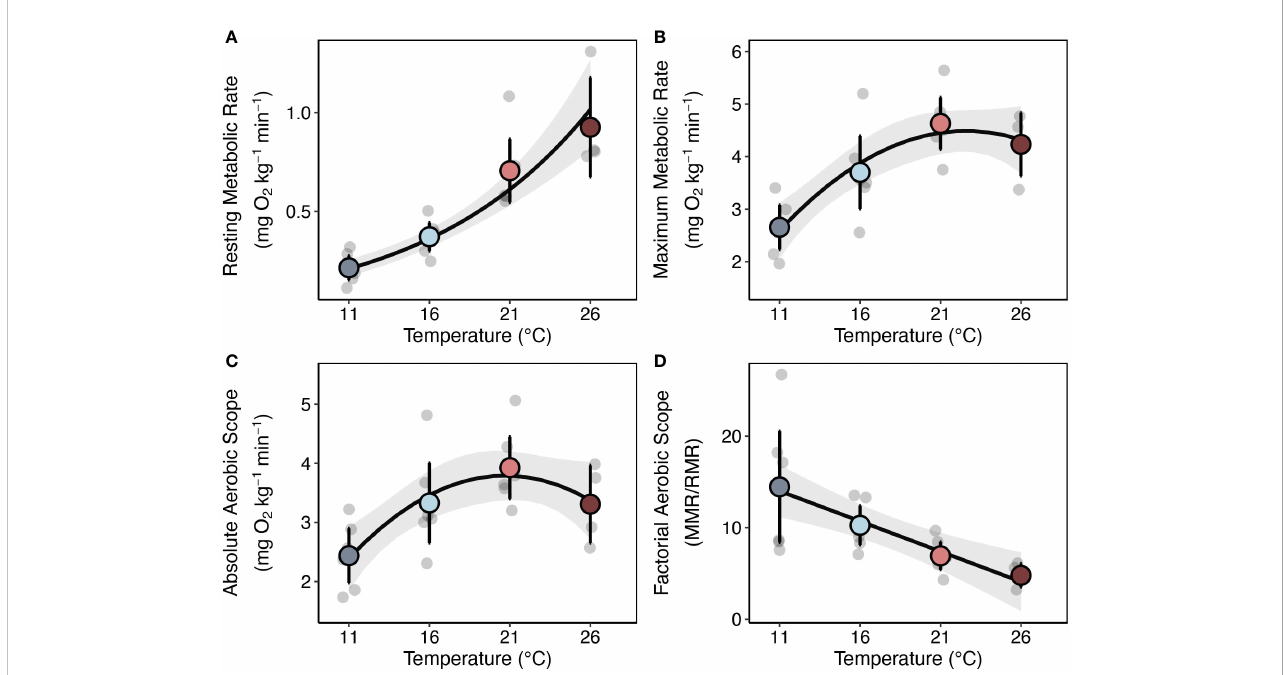
FIGURE 2 Temperature Effects on Lobster Metabolism. (A) Resting metabolic rates (RMR), (B) maximum metabolic rates (MMR), (C) absolute aerobic scopes (AAS = MMR – RMR), and (D) factorial aerobic scopes (FAS = MMR / RMR) measured for individual lobsters (light gray points) at 11, 16, 21, and 26°C (n = 6 for all treatments except 26°C, where n = 4). Colored points represent treatment means and bars are equal to 95% con fi dence intervals. Gray dots represent jittered raw data. Lines and gray shading are the mean ± 95% CI ’ s for fi tted models. See Methods for details on the models fi t to each